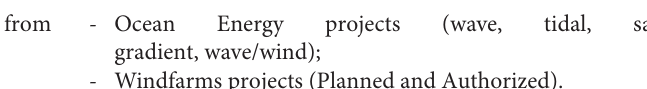
Data in the following set of human activities was obtained from the EMODnet